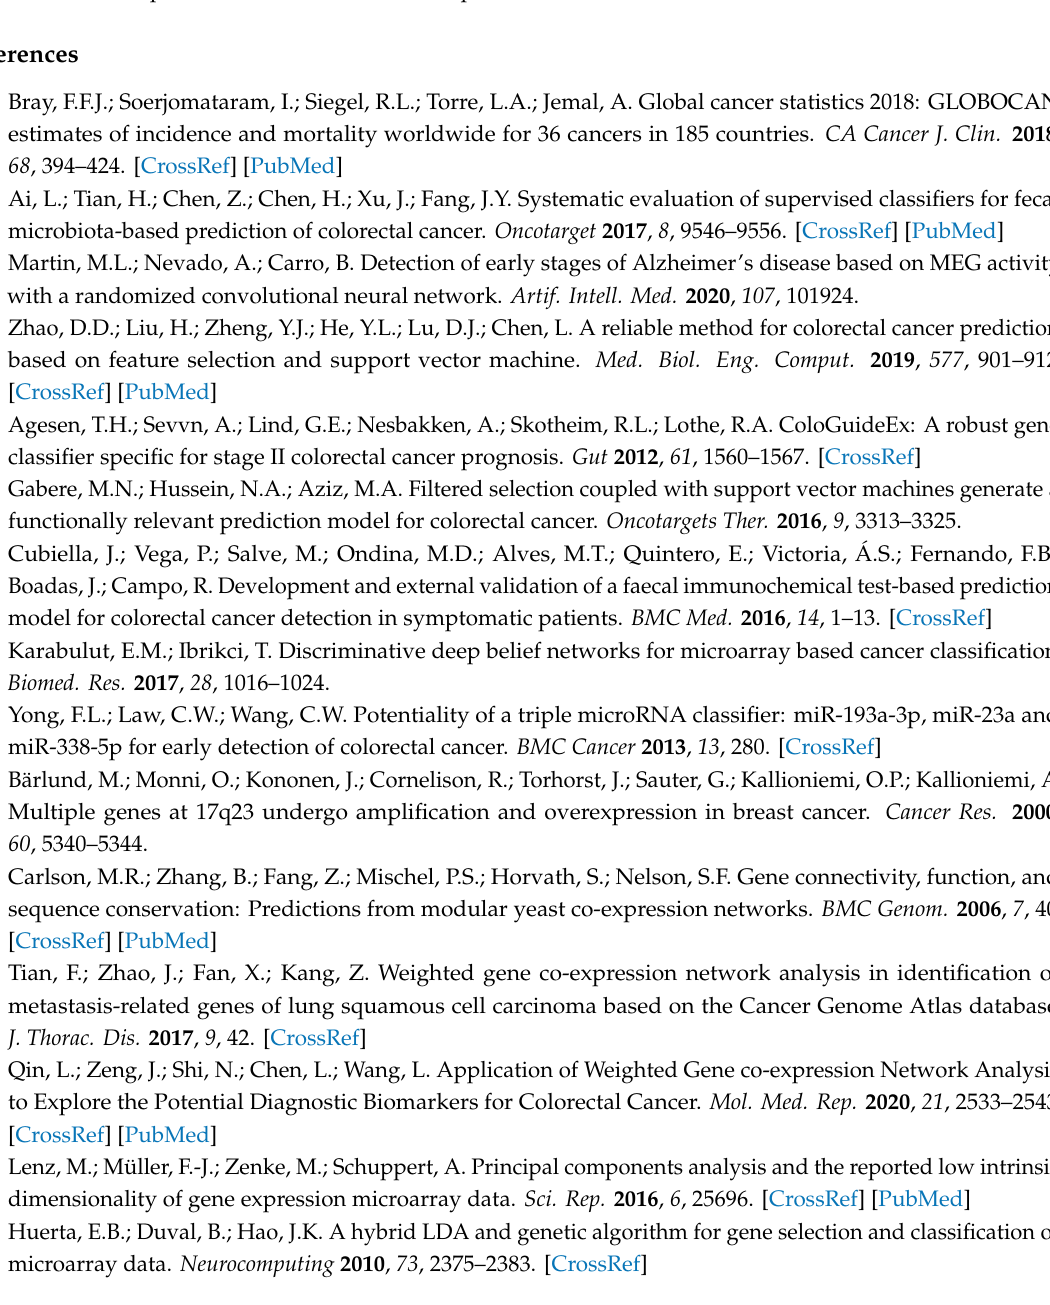
Figure S1: Volcano map of differential genes between colorectal cancer sample and normal sample. Figure S2: Soft threshold Screening. Figure S3: GO Functional enrichment analysis. Figure S4: KEGG function enrichment analysis. Table S1: Sample distribution of four datasets. Table S2: Soft Threshold Screening for Network